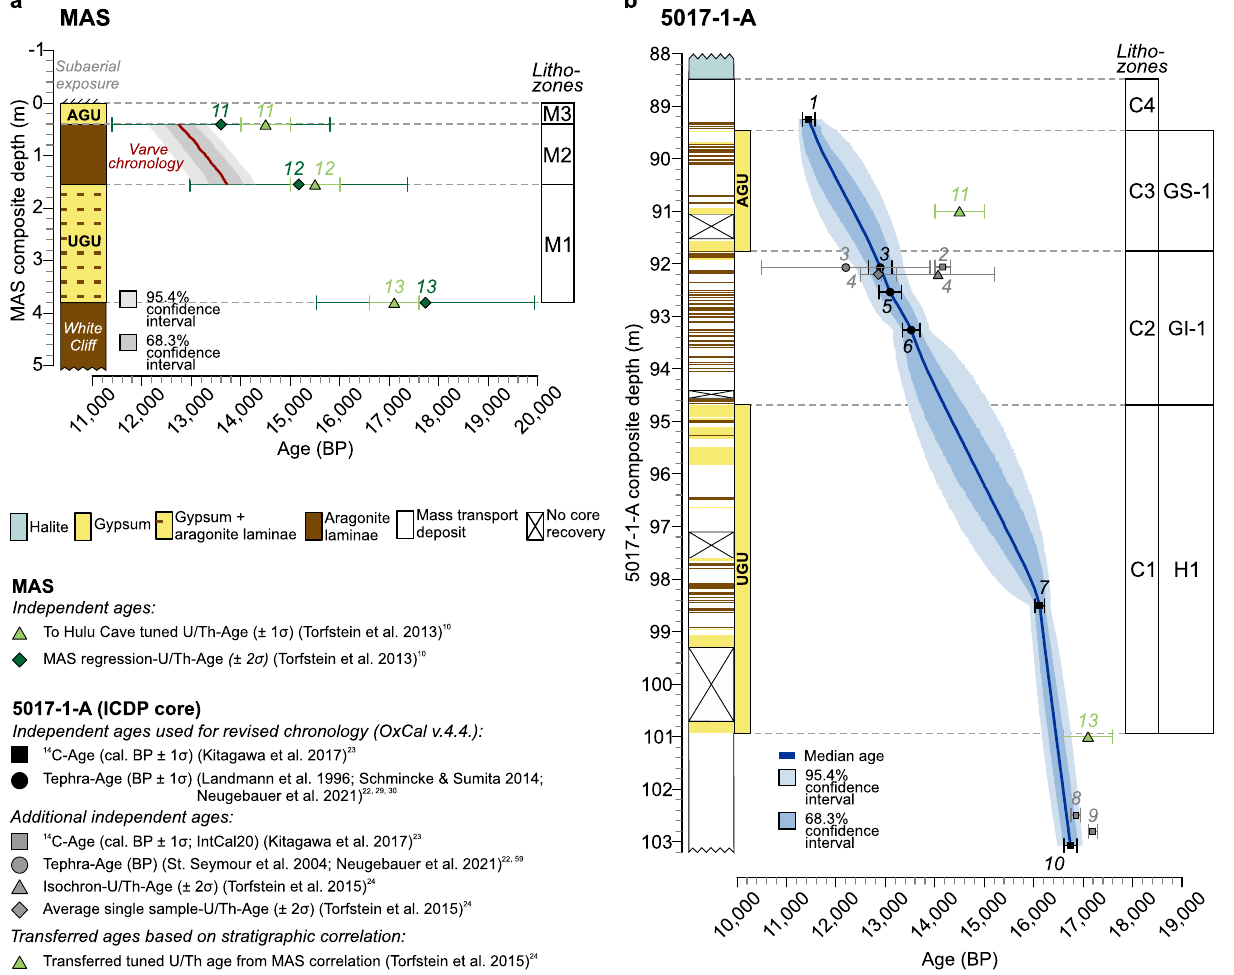
Figure 2. Age model and published ages for Masada (MAS) and the ICDP core (5017–1-A). ( a ) Published U/ Th ages for Masada 10 and varve chronology (this study). The MAS varve chronology is anchored at the base of the AGU and provides a minimum estimate for the time interval between the UGU and AGU. Simplified lithology on the left. ( b ) Bayesian age depth model constructed with OxCal 26–28 (“Methods”) for the ICDP core. Numbering of ages according to Table S1. Black colored ages are included in the age model. Simplified lithology on the left. See “Methods” for discussion of ages excluded from the age modelling. AGU Additional Gypsum Unit, UGU Upper Gypsum Unit, H1 Heinrich event 1, GI-1 Greenland Interstadial 1, GS-1 Greenland Stadial